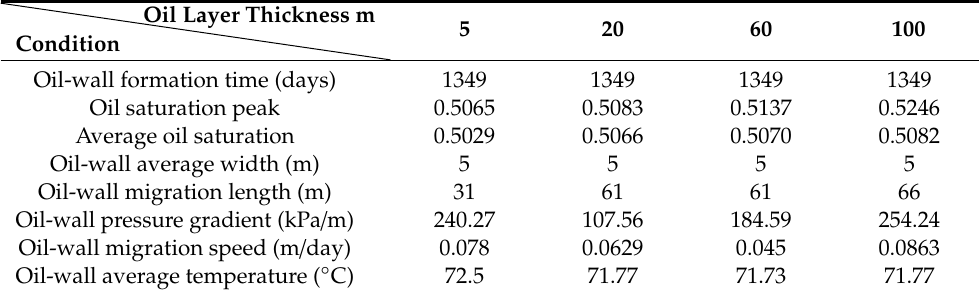
Table 19. Characteristic parameters of oil-wall with di ff erent formation thickness.